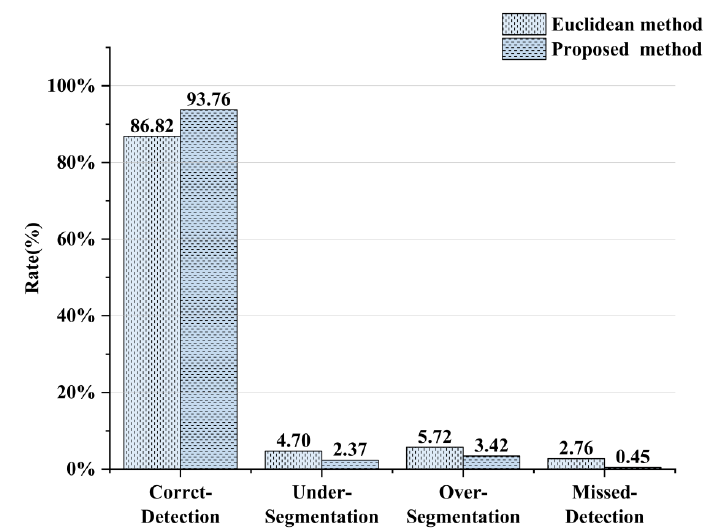
Figure 16. Comparison of detection results. Figure 18. Comparison of detection results.